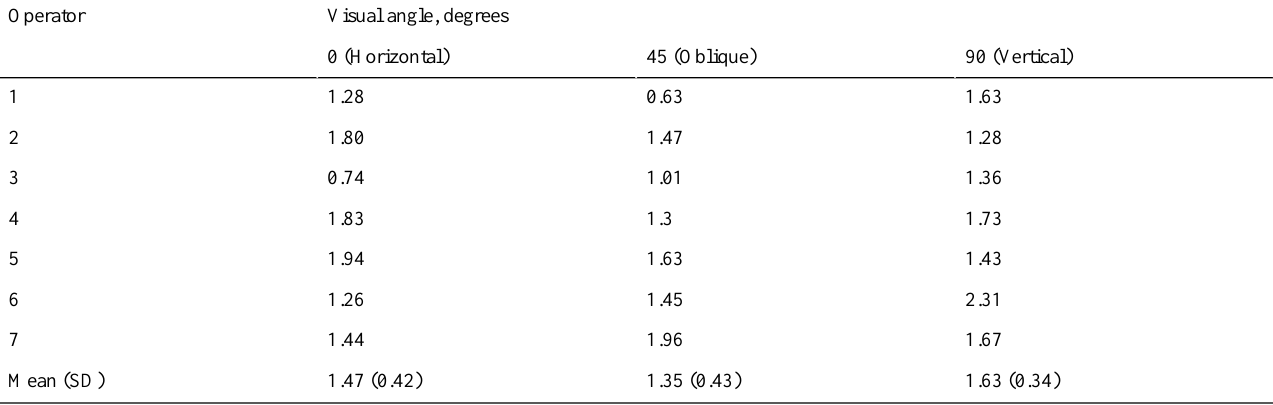
Table 2. Static error tested without light under different visual angles (mm).